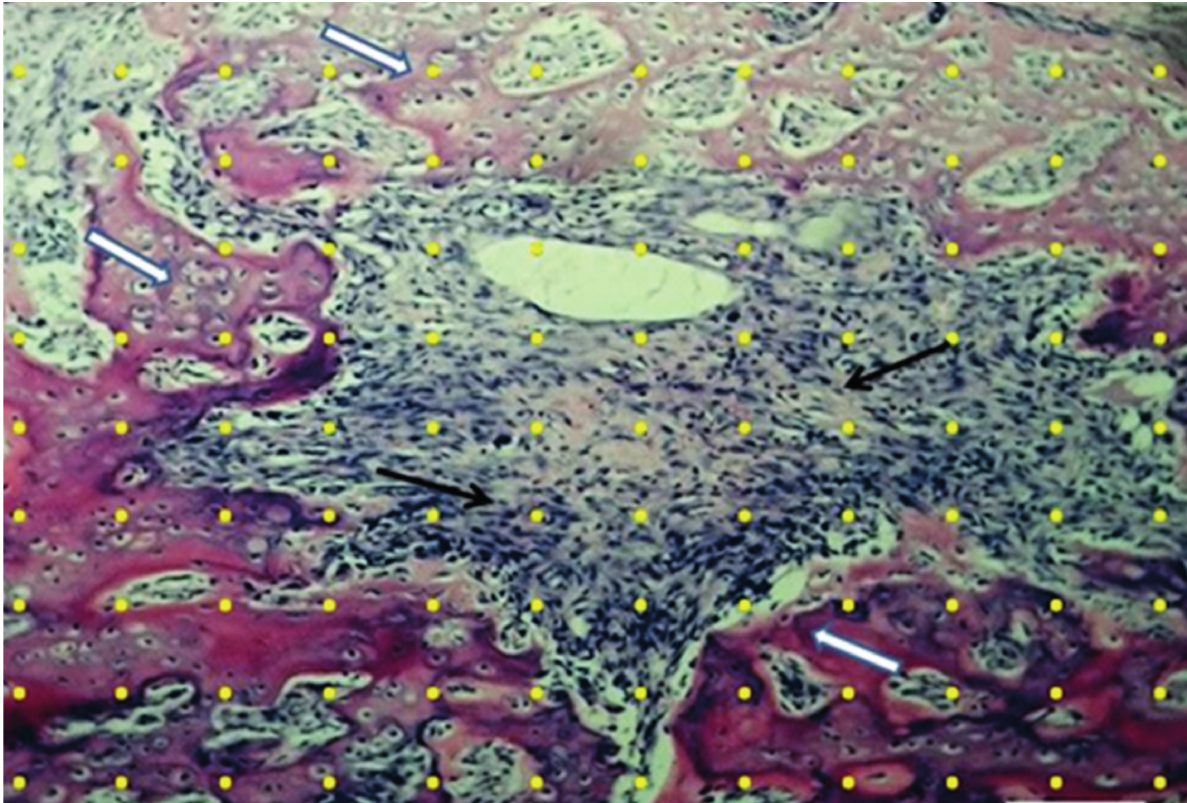
Figure 1 - Test-system with 132-points (yellow points) superimposed at a histological section from the fracture trace, used to quantify the newly formed bone (white arrows) in the four groups of rats Note: Black arrows show nuclei of osteogenic cells. Bar: 100 micrometers μ m. Source: Research